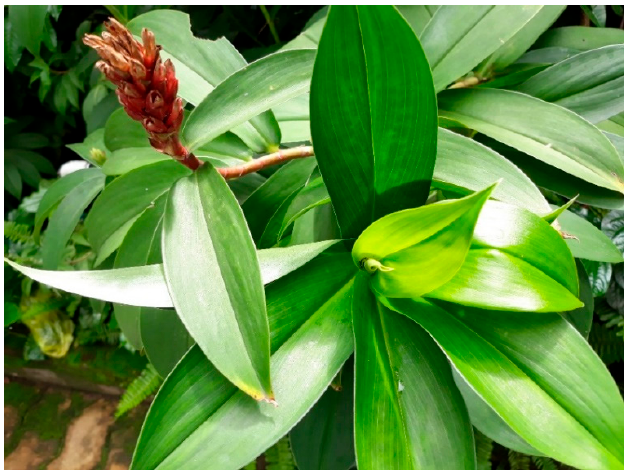
Figure 16. Costus pictus D. Don.